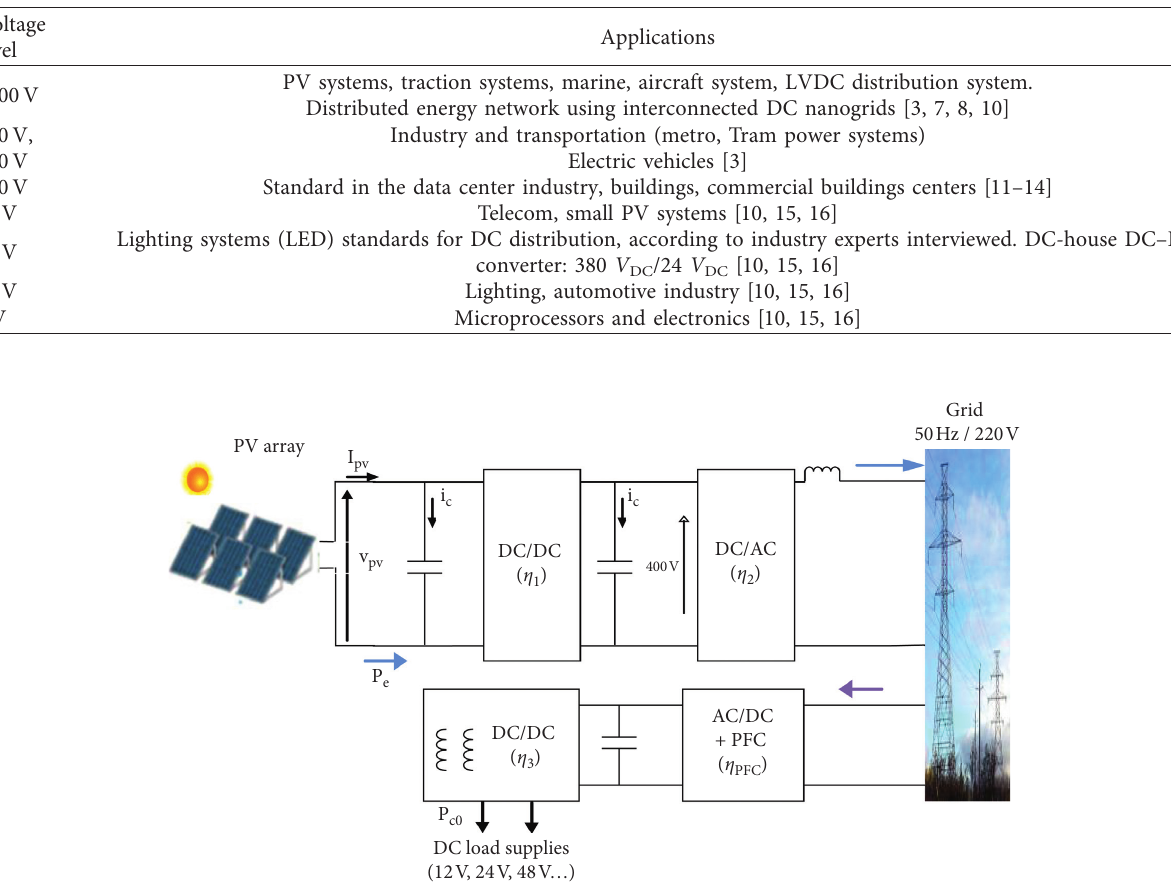
Figure 1: Classical configuration (syst1) of the on-grid LVAC PV system and DC load powered from AC